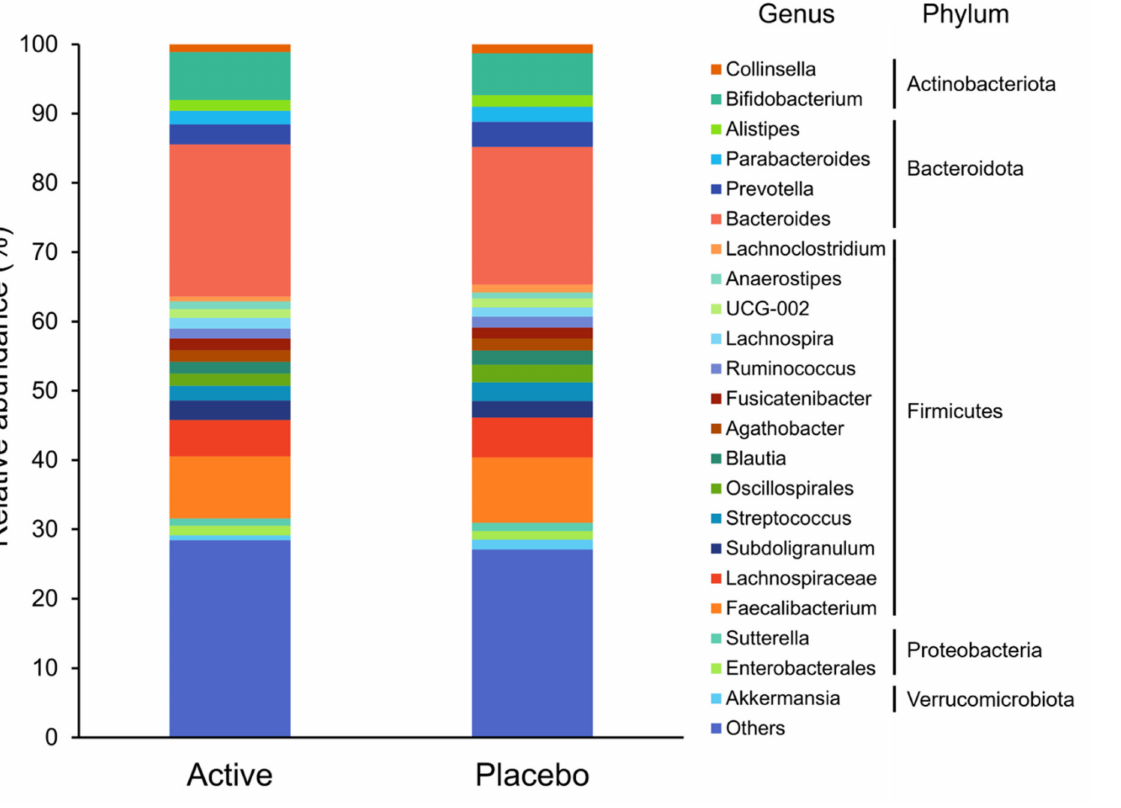
Figure 2. The composition of the gut microbiota at the genus level. Taxa with low relative abundances of <1% are included in